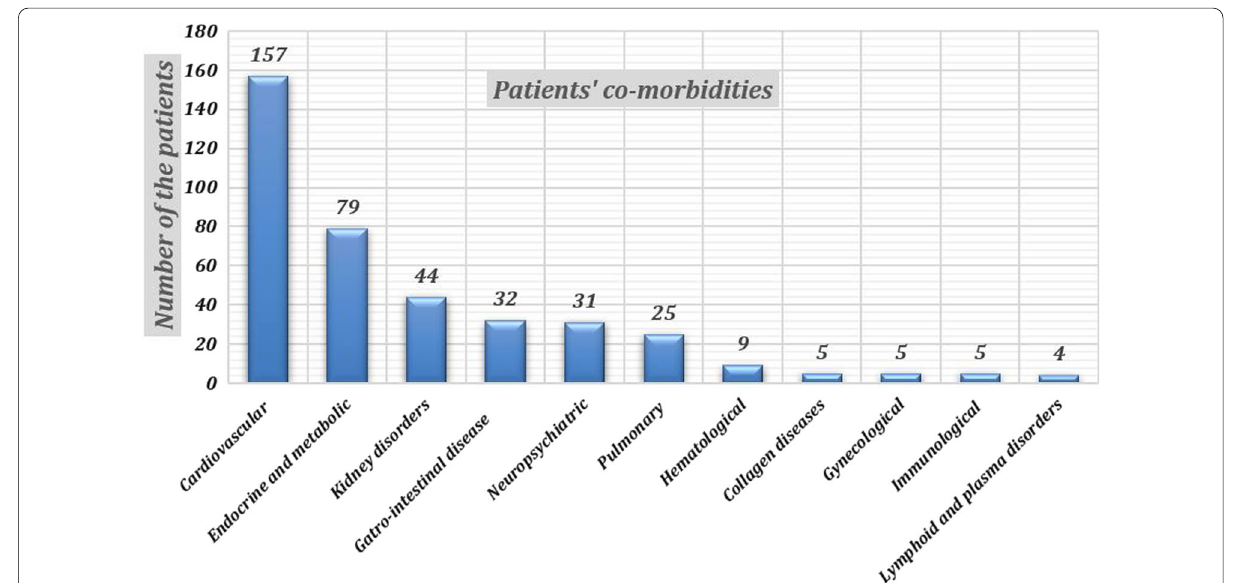
Fig. 1 Illustrating the incidence of different comorbidities between our study